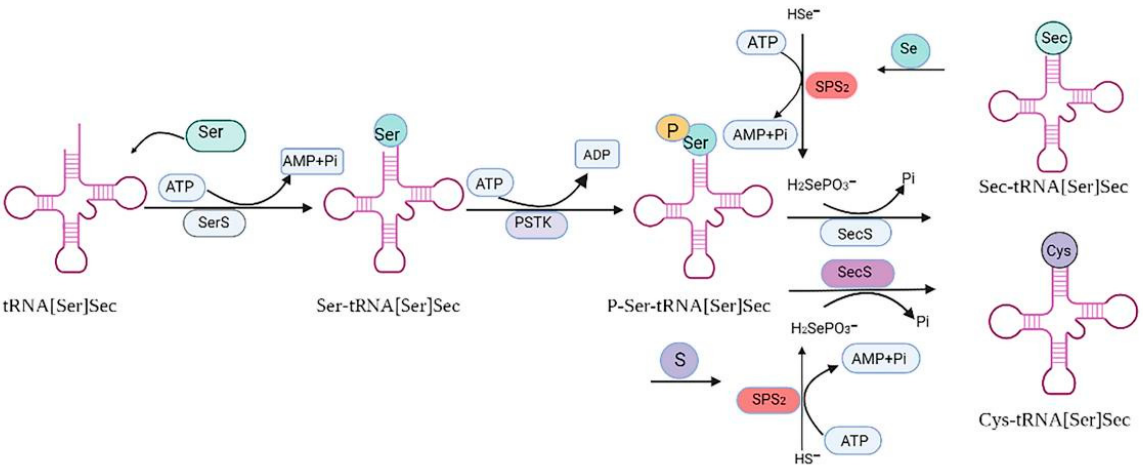
Figure 3. Synthesis of